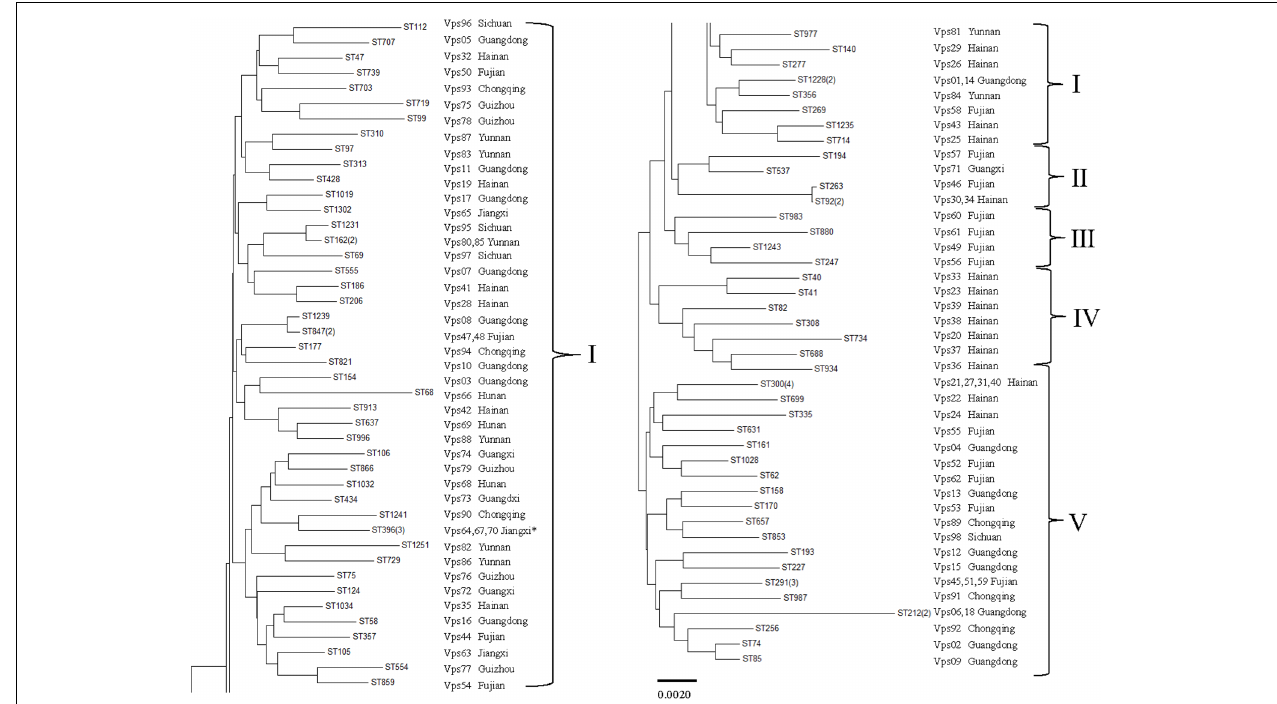
FIGURE 3 | Multilocus sequence typing (MLST) minimum evolution tree of V. parahaemolyticus isolates (“ ∗ ” stand for “Jiangxi, Hunan,